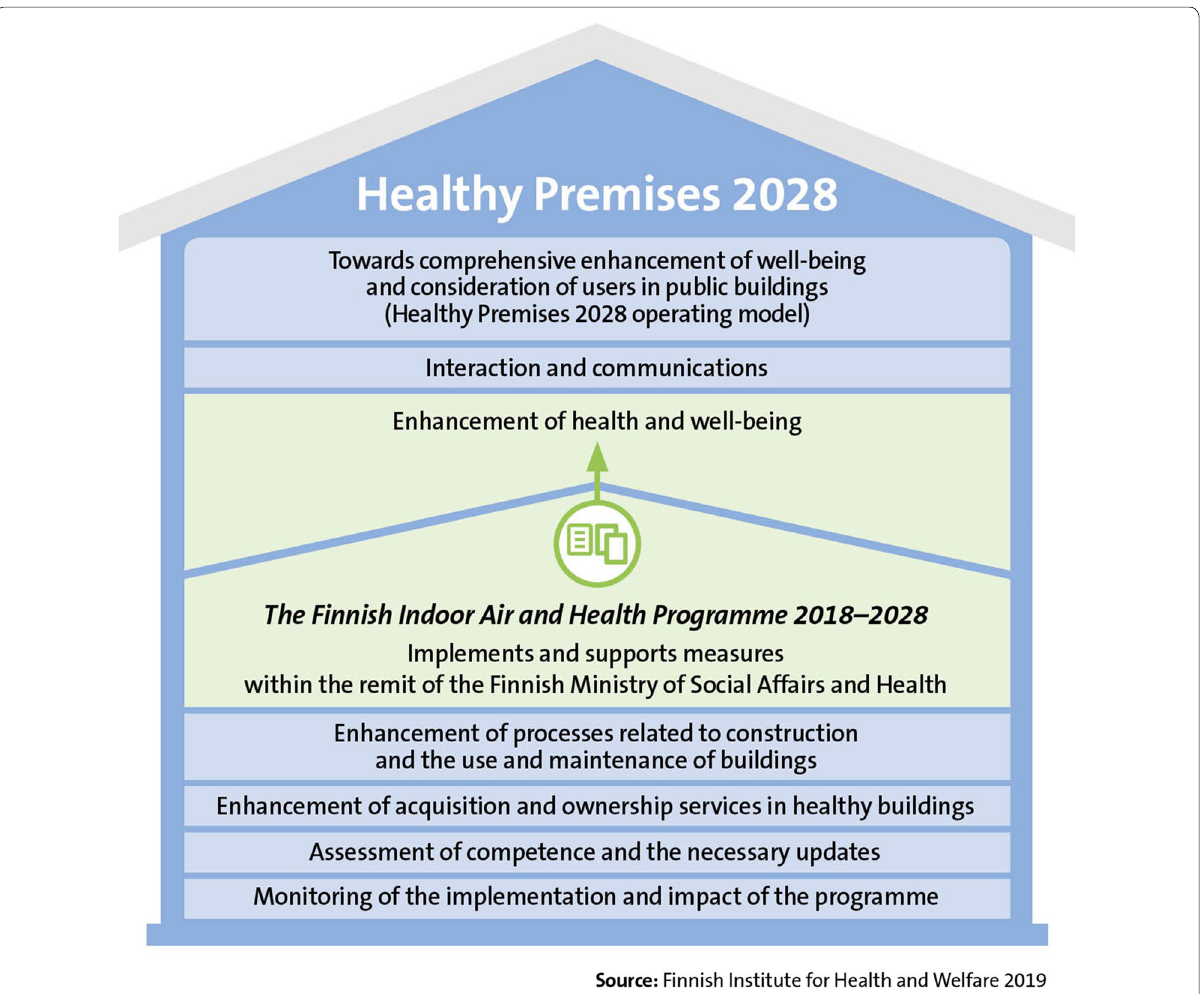
Fig. 1 Main focus areas of Finnish Healthy Premises 2028 Programme. The Finnish Indoor Air and Health Programme implements and supports these measures (Enhancement of health and well‑being) and closely collaborates with programme’s other